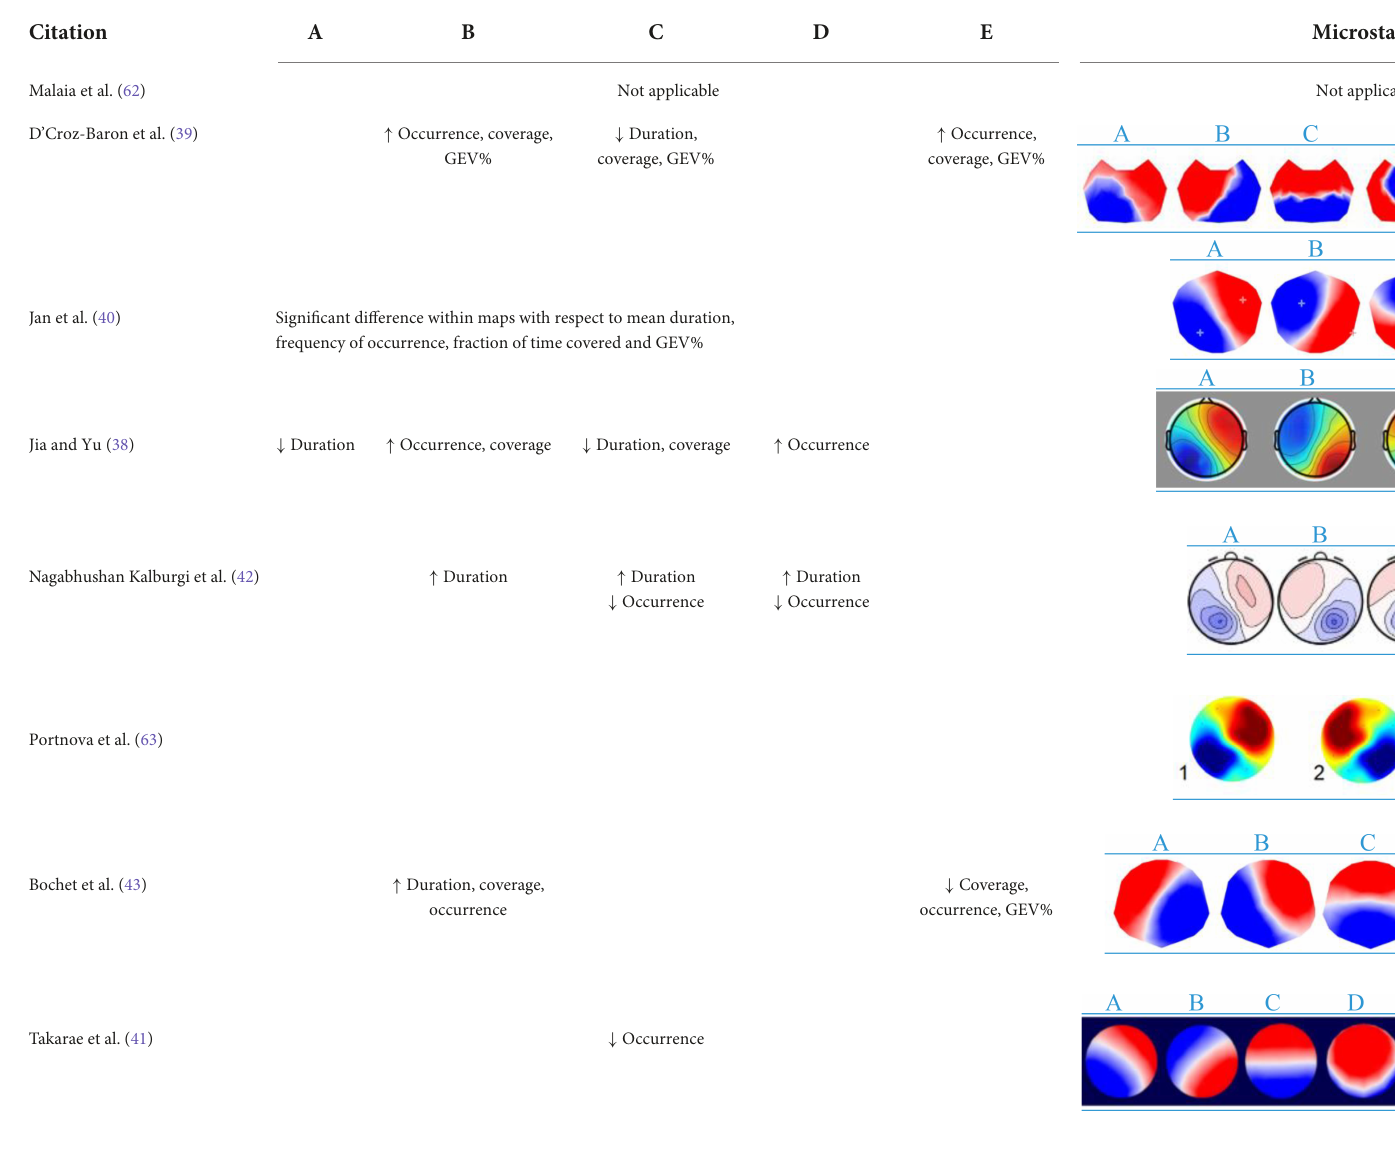
TABLE 2 Visualization of key microstate